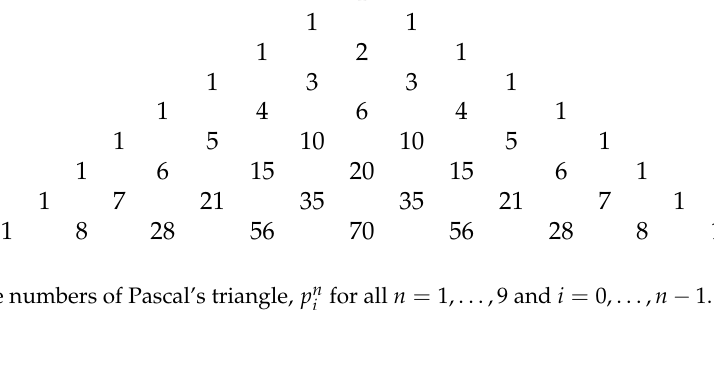
Figure 1. The numbers of Pascal’s triangle, p n